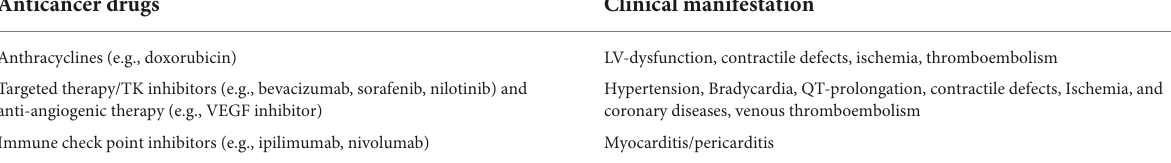
TABLE 1 Some of the anticancer drugs-mediated adverse effects in cardiovascular system. Anticancer drugs Clinical